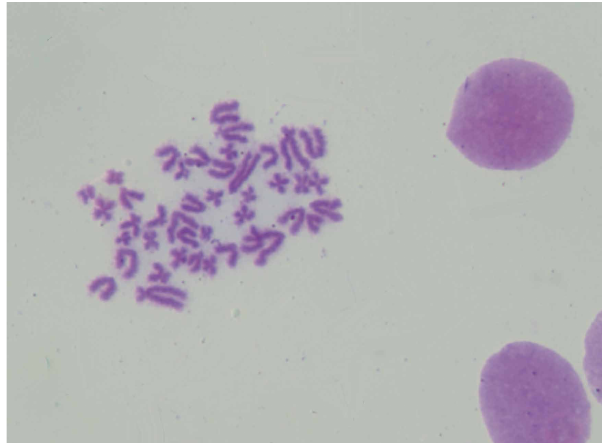
Figure 8: OM-MSCs’ karyotype (P8), showing structural normality, normal number of chromosomes (42, XY) and absence of neoplastic alterations. These characteristics demonstrate the chromosomal stability of these cells.